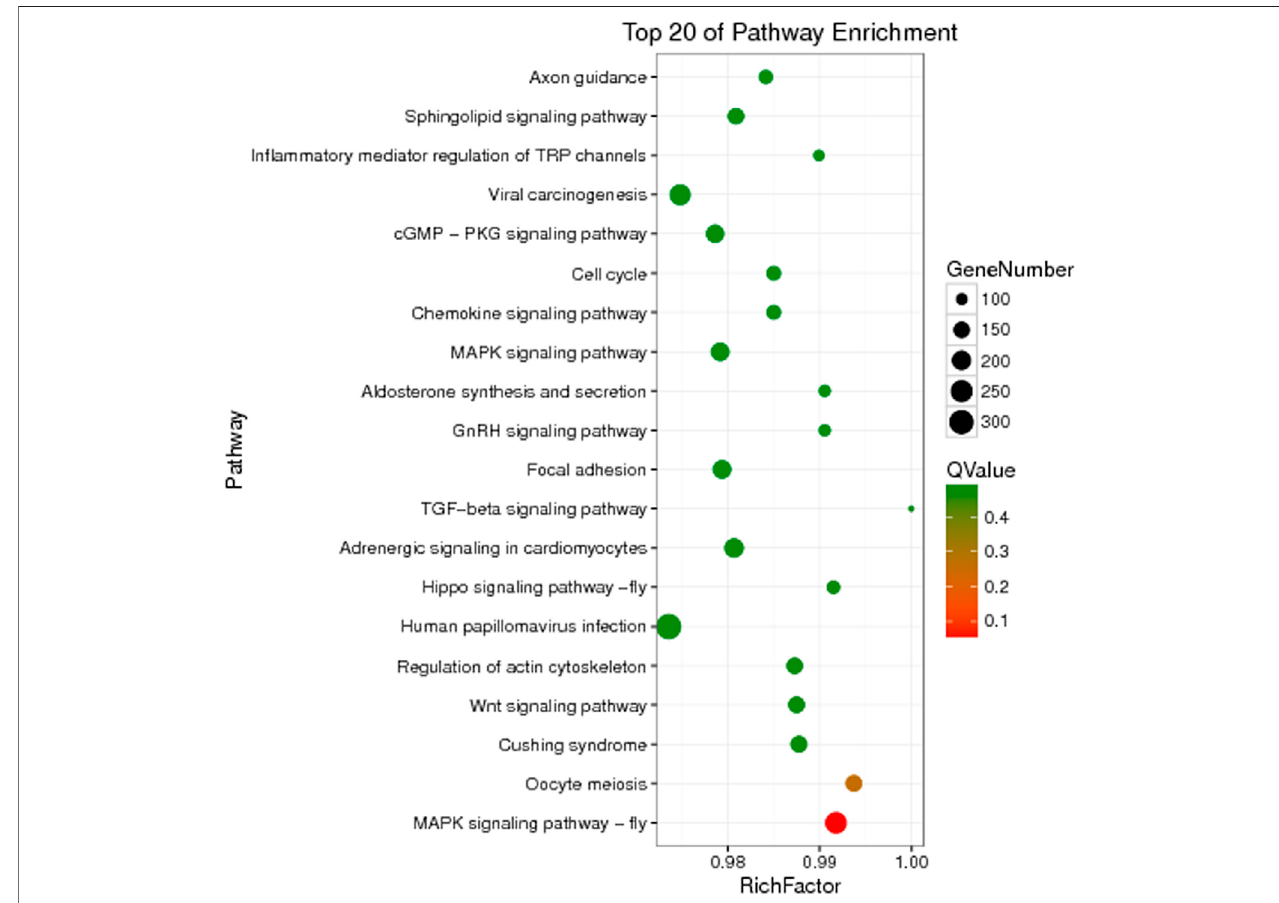
FIGURE 3 | KEGG enrichment analysis results of speci fi c genes of Bactrocera dorsalis (Hendel).